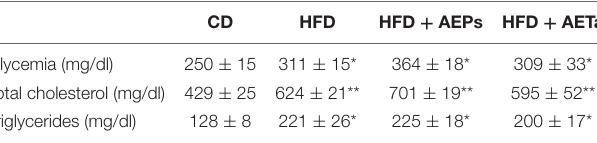
Values are mean (n = 5–7) ± SEM. Animals were fed 8 weeks with HFD and treated with AEPs or AETa in the last 4 weeks. ApoE-KO, apolipoprotein E-knockout; AEPs, aqueous extract of Prosopis strombulifera; AETa, aqueous extract of Tessaria absinthioides.